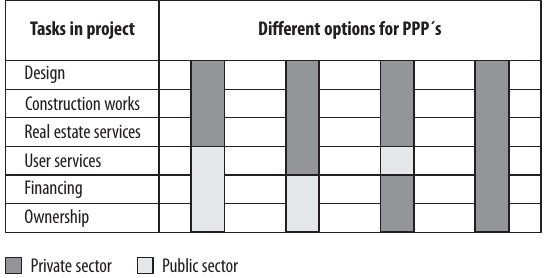
Figure 1. Different options for